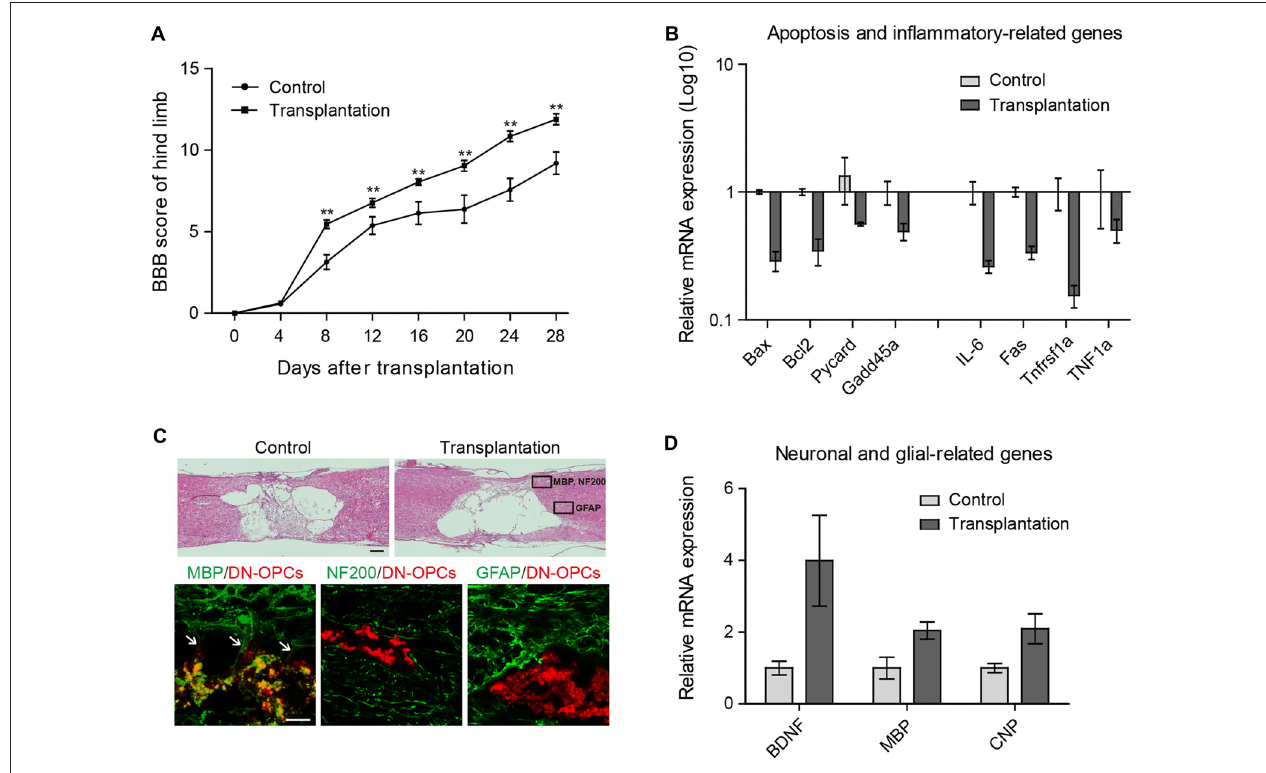
FIGURE 4 | Functional recovery after transplantation. (A) Basso beattie bresnahan (BBB) Score. The Mean BBB motor score for hind limb in control and DN-OPCs transplantation groups after spinal cord injury (SCI) surgery. (B) Quantitative RT-PCR analysis. Apoptosis and inflammation related genes in spinal cord. Graphs represent changes after normalization to control. (C) H&E Staining of control and DN-OPCs transplantation groups and immunohistochemical analysis of DN-OPCs transplantation groups. Myelin basic protein (MBP) is indicated with white arrows (D) Quantitative RT-PCR analysis. Brain-derived neurotrophic factor (BDNF), MBP and CNP in spinal cord. Graphs represent changes after normalization to control. Data are presented as the means ± SEM ( n = 3). Scale bar: 500 µ m. ∗∗ p <